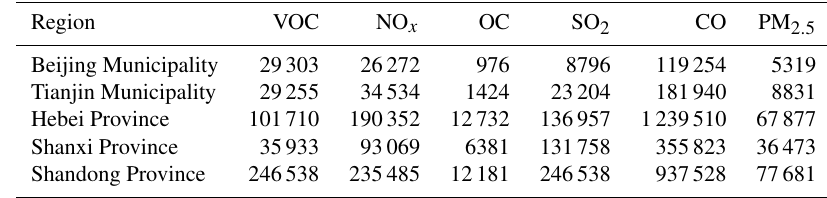
Table 1. Emissions of major anthropogenic species in July 2013 (Unit: 10 6 gmonth − 1 ) .